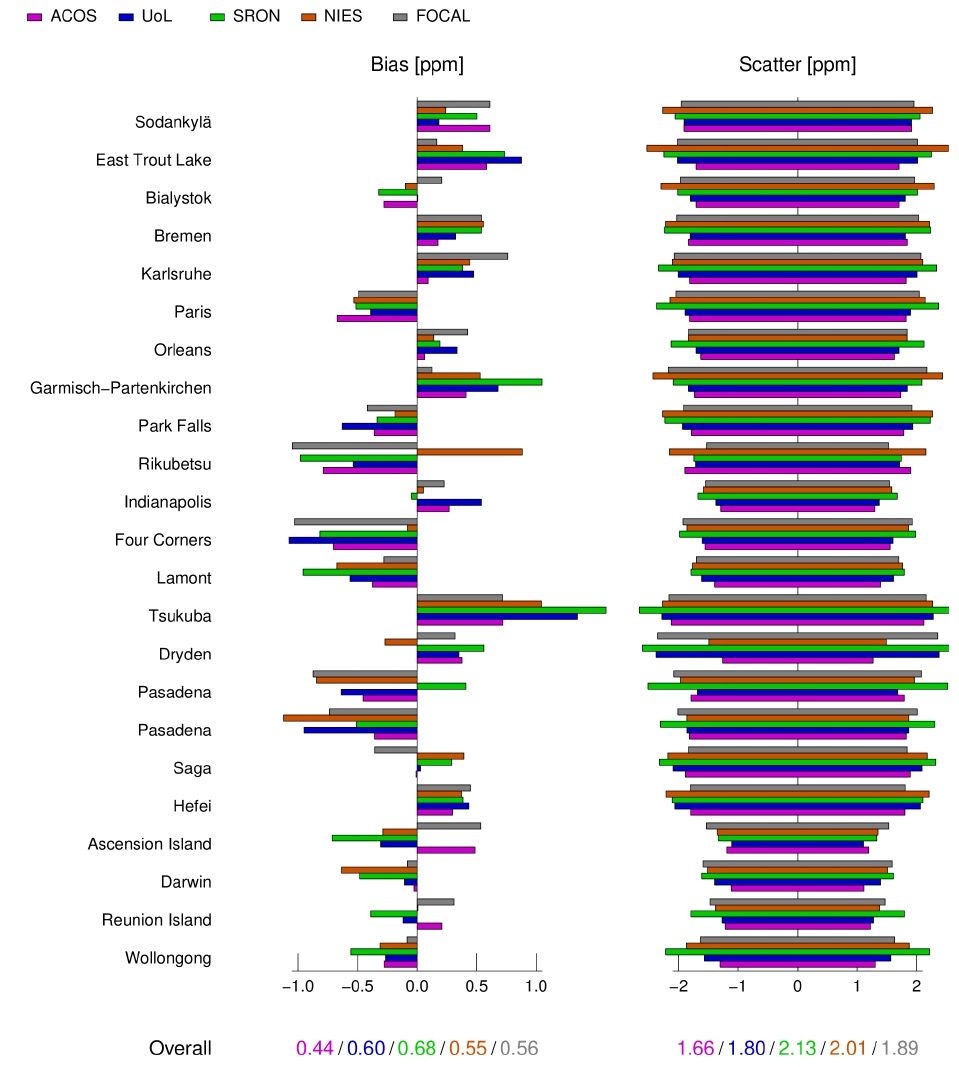
Figure 16. Overview of TCCON validation results for